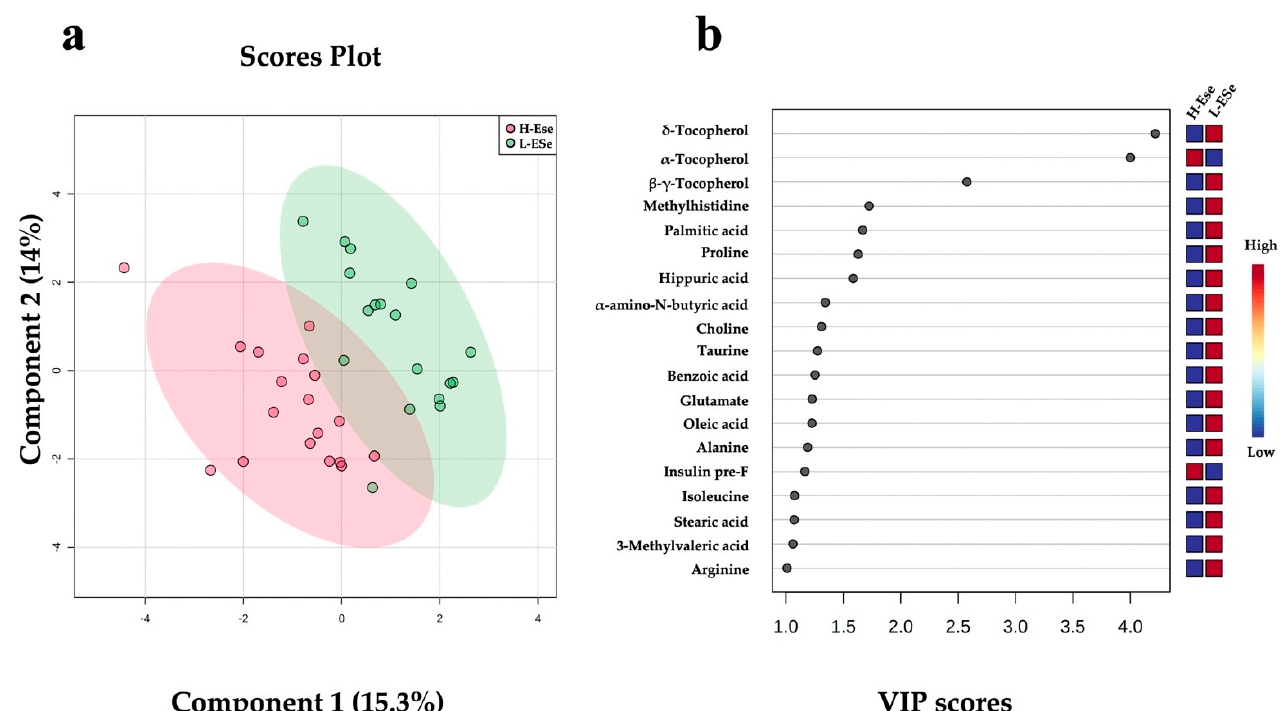
Figure 4. Discriminant analysis of fecal metabolites of dairy cows fed high vitamin E and Se (H-ESe) or low vitamin E and Se (L-ESe). ( a ) Two-dimensional partial least squares discriminant (PLS-DA) score plot. ( b ) Variable importance projection (VIP) scores analysis based on Component 1 of the PLS-DA used to rank the relative contribution of metabolites to the variance between dietary treatments. Treatments were two plots differing in basal concentrations of vitamin E and Se (high: 200 IU/kg vit. E and 1.2 mg/kg Se; low: 20 IU/kg vit. E and 0.3 mg/kg Se). Fecal metabolite data were obtained using a LC–MS/MS custom assay. Insulin pre-F = plasma insulin prior to